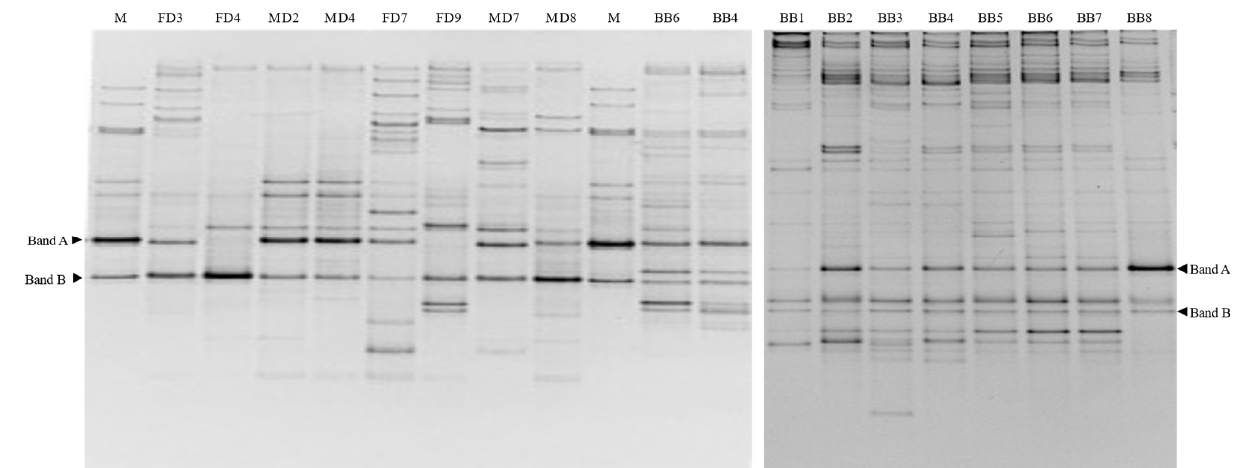
Figure 4. Representative DGGE for detection of Streptomyces antifungal isolates in samples derived from the dung beetles ( left ) and brood balls ( right ). (FD3, FD4) Digestive tracts of female dung beetles collected in 2013; (MD2, MD4) Digestive tracts of male dung beetles collected in 2013; (FD7, FD9) Digestive tracts of female dung beetles collected in 2014; (MD7, MD8) Digestive tracts of male dung beetles collected in 2014; (BB1-BB8) Brood ball; M: Marker (Band A: AT92, AT95 and AT99, Band B: AT20 and AT67]).